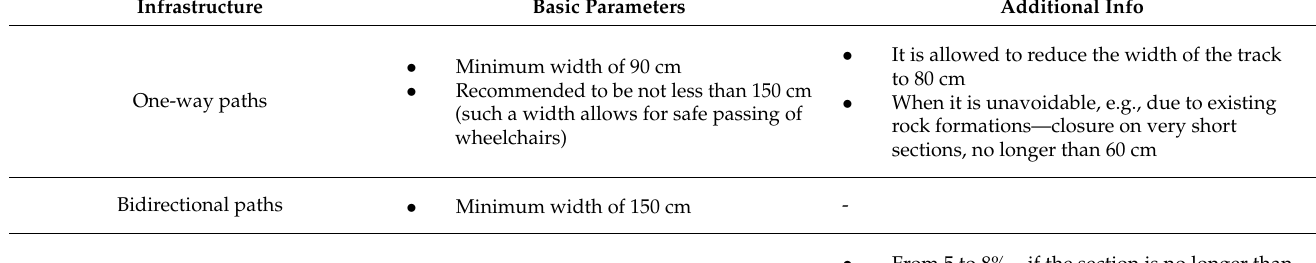
Table 3. Technical aspects of selected elements of the recreational forest management infrastructure (based on [22]).